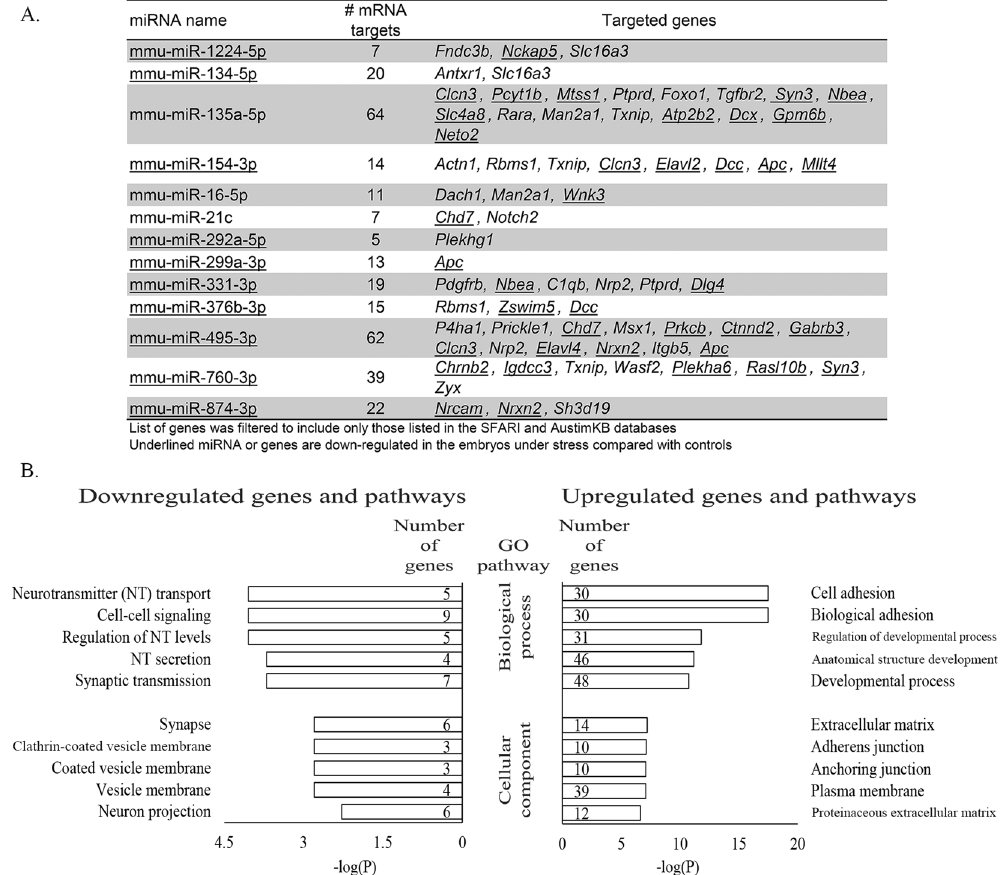
Figure 5. Autism spectrum disorder (ASD)-related DEGs targeted by DE miRNA. ( A ) List of 13 DE miRNA (p ≤ 0.05) and their DEGs gene targets (p ≤ 0.05) in the WT embryos in response to stress. ( B ) Analysis of gene ontology for biological process and cellular component for targeted, ASD-related DEGs for downregulated (left panel) and upregulated (right panel)